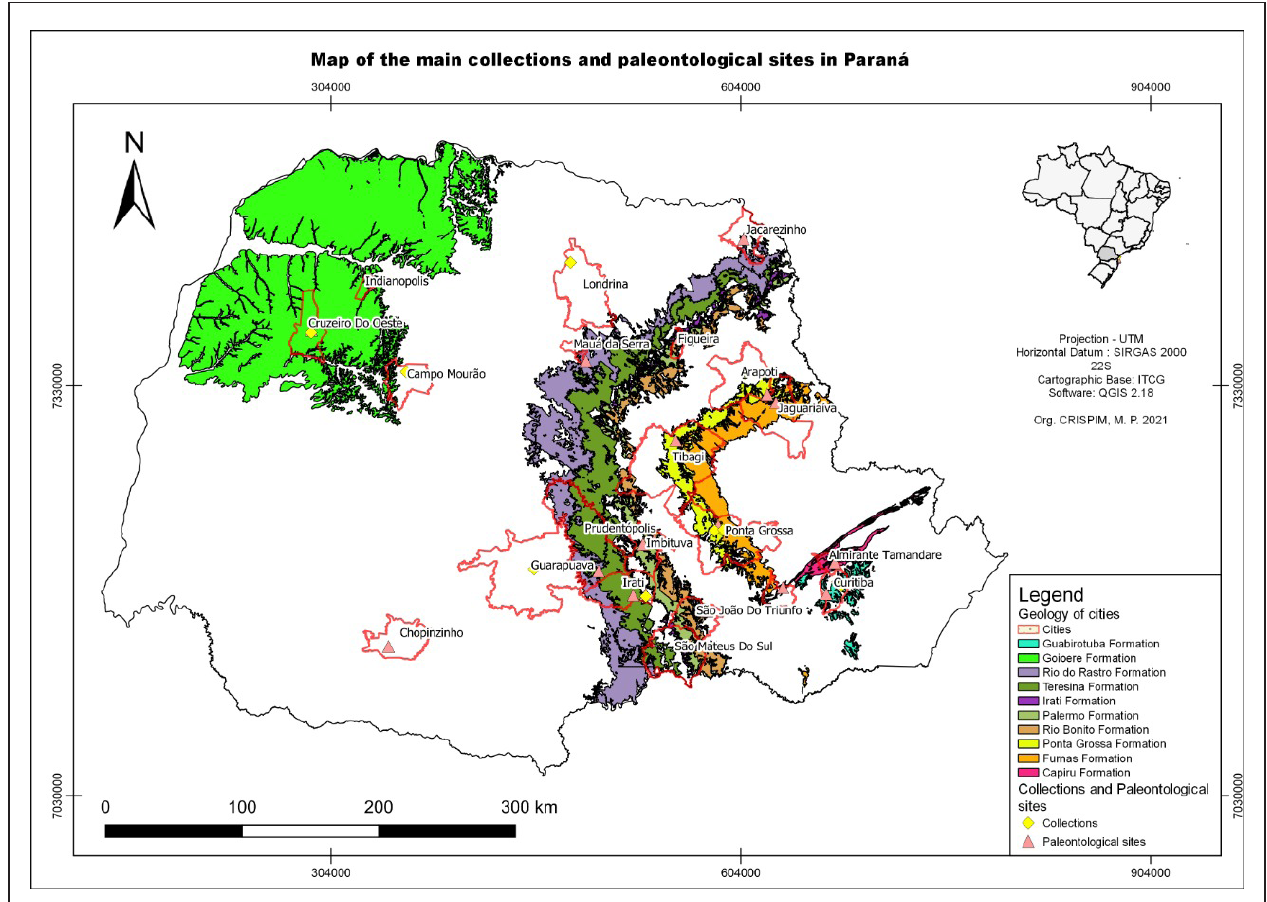
FIGURE 1. Map of Paraná State with location of the cities that house in their territories collections and/or paleontological sites of great scientific and educational